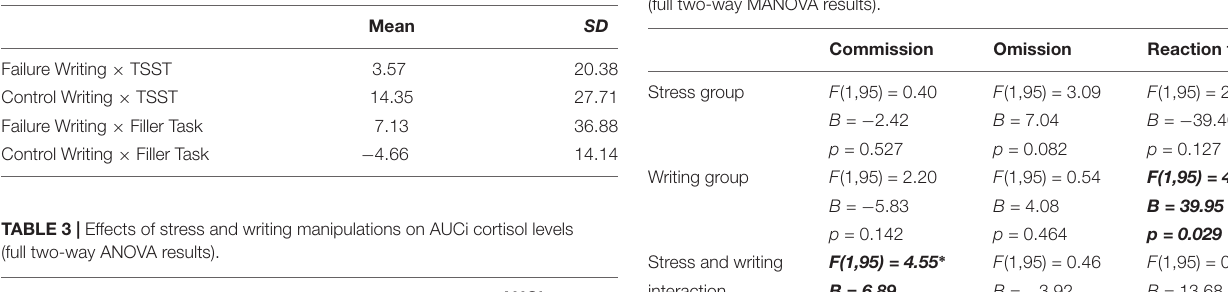
TABLE 2 | Area under the curve from increase (AUCi) values across conditions.